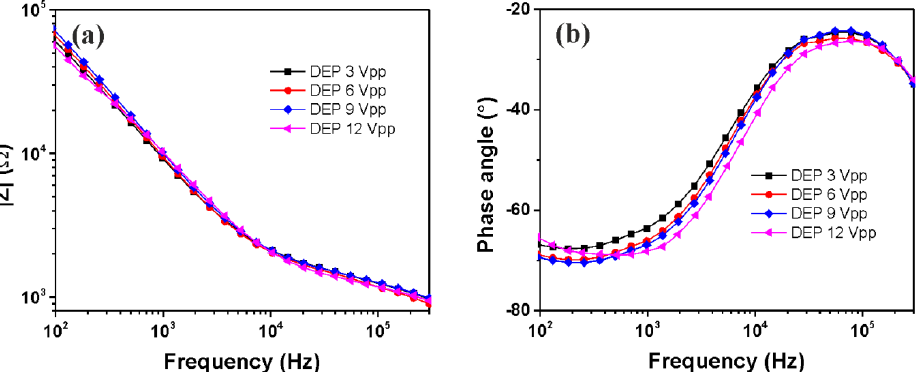
Figure 4. Impedance magnitude (a) and phase angle (b) of trapped HT-29 cells at different DEP operating voltages. Table 1. The average values of the impedance magnitude and phase angle, the standard deviation (SD), and the relative standard deviation (RSD) calculated between the electrodes at different frequencies.